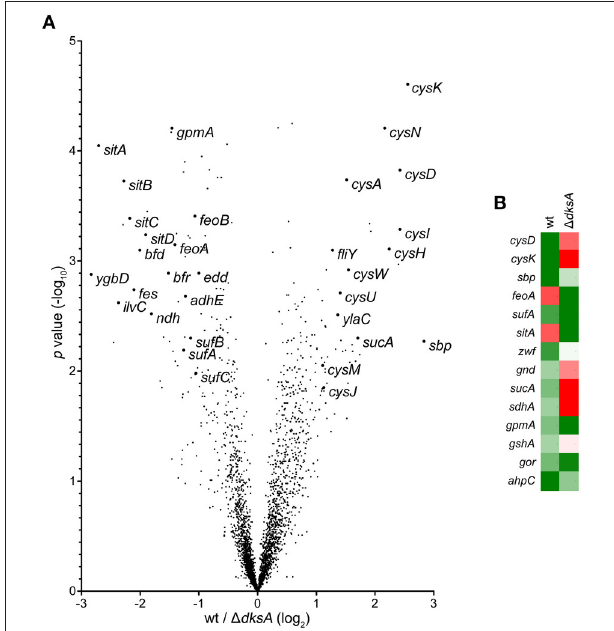
FIGURE 2 | DksA-dependent transcriptional regulation in • NO-treated Salmonella . (A) Positively and negatively regulated loci are represented as a function of the p -value using a volcano plot. Expression is depicted as fold change of the ratio of • NO-treated wild-type (wt) and 1 dksA Salmonella as compared to control conditions. (B) Heat map representing the ratio of selected up-regulated (green) and down-regulated (red) transcripts between • NO-treated and untreated controls.